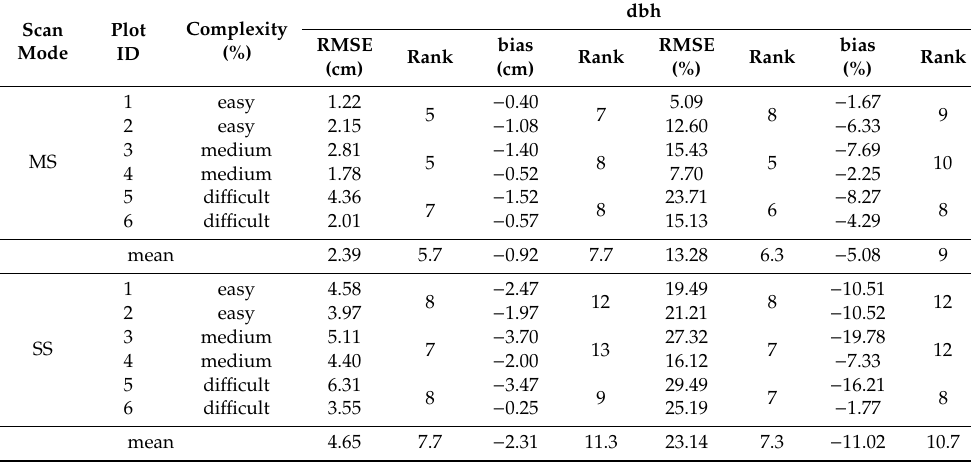
Table 8. Comparison of dbh estimation with the benchmark